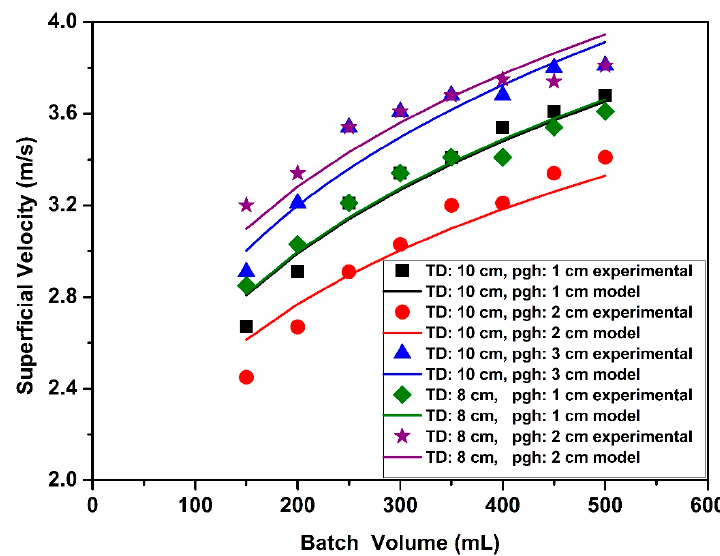
Figure 7. Comparison of experimental data with model predictions for superficial velocity at onset of circulatory motion in the bed. (TD: Wurster tube diameter, pgh: partition gap height).